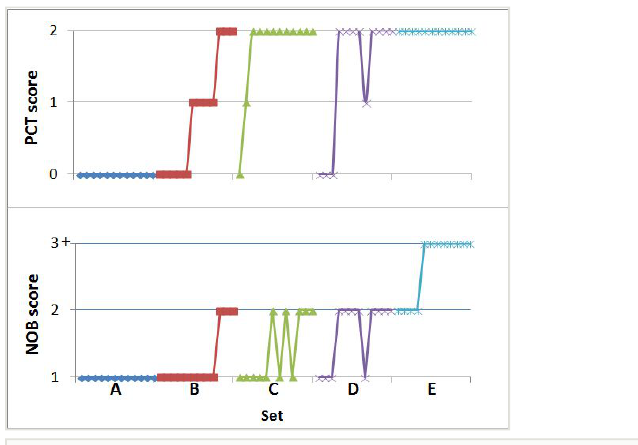
Figure 9. Graphical representation of neurobiological requirements for Standard Raven's Progressive Matrices questions. The NOB score (bottom) and the PCT score (top) as a function of question number. The fi ve sets of 12 questions are shown with di ff erent markers.